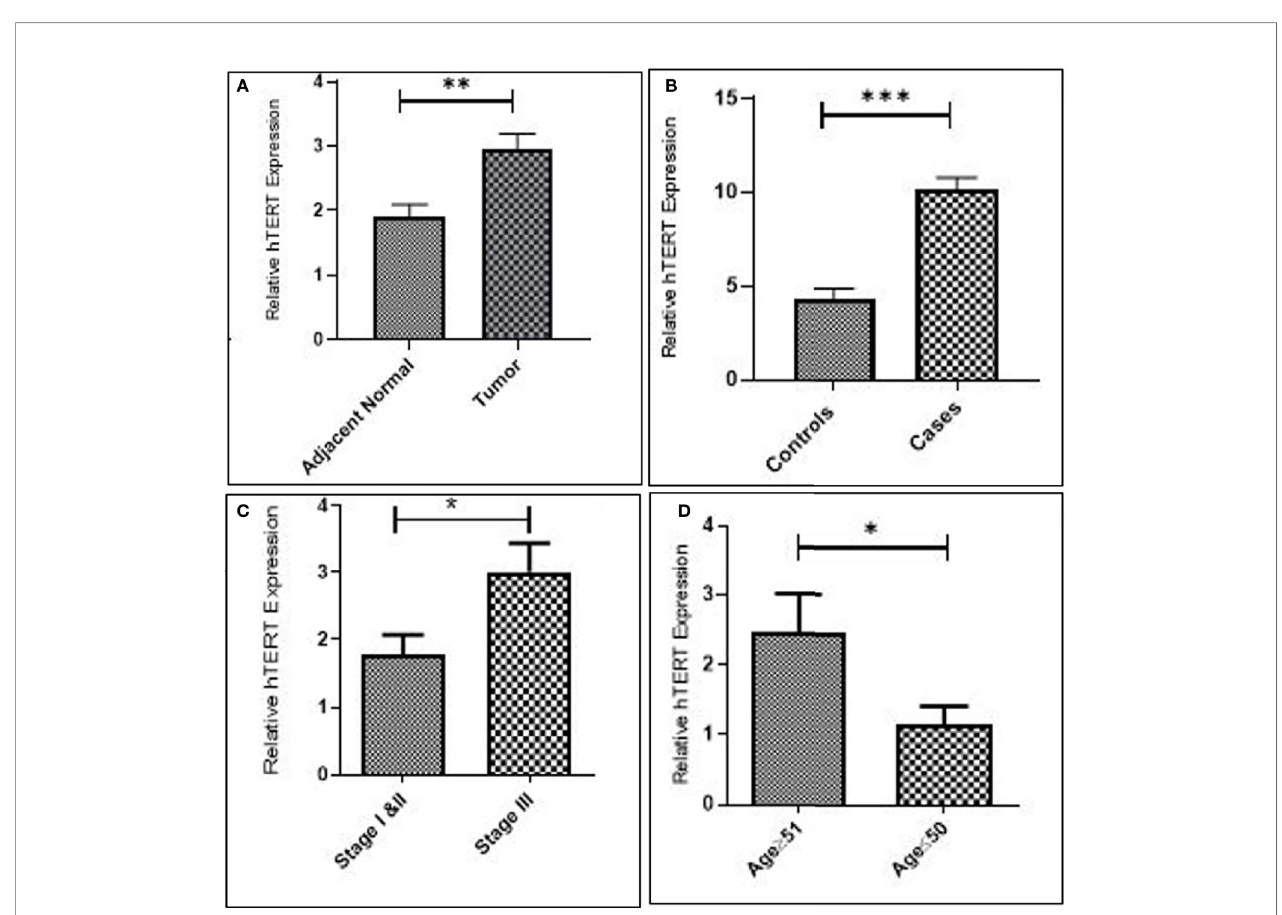
FIGURE 2 | Increased expression of hTERT in gastric cancer. (A) Tissue. (B) Blood. (C) Late stage. and (D) Advanced age.